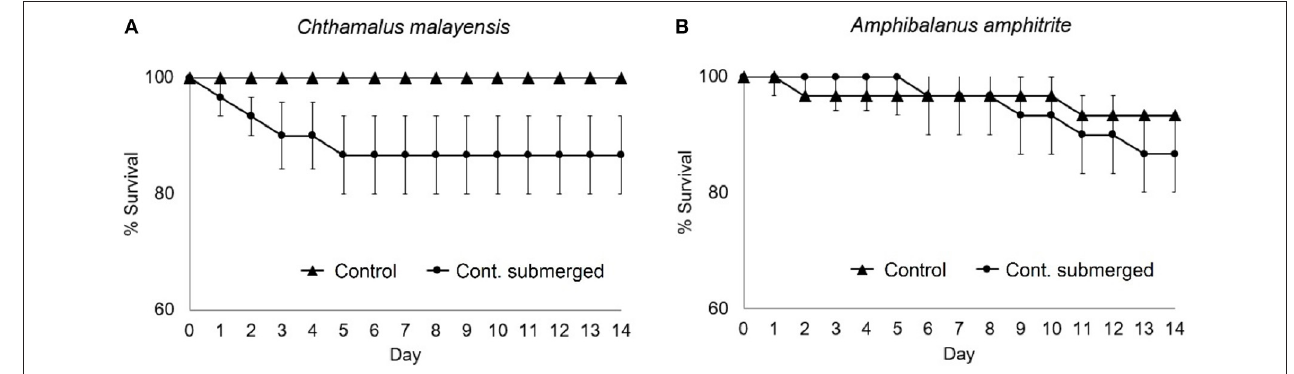
FIGURE 6 | Percentage of survival (mean ± SE) of barnacles in submersion experiment. (A) C. malayensis and (B) A. amphitrite .